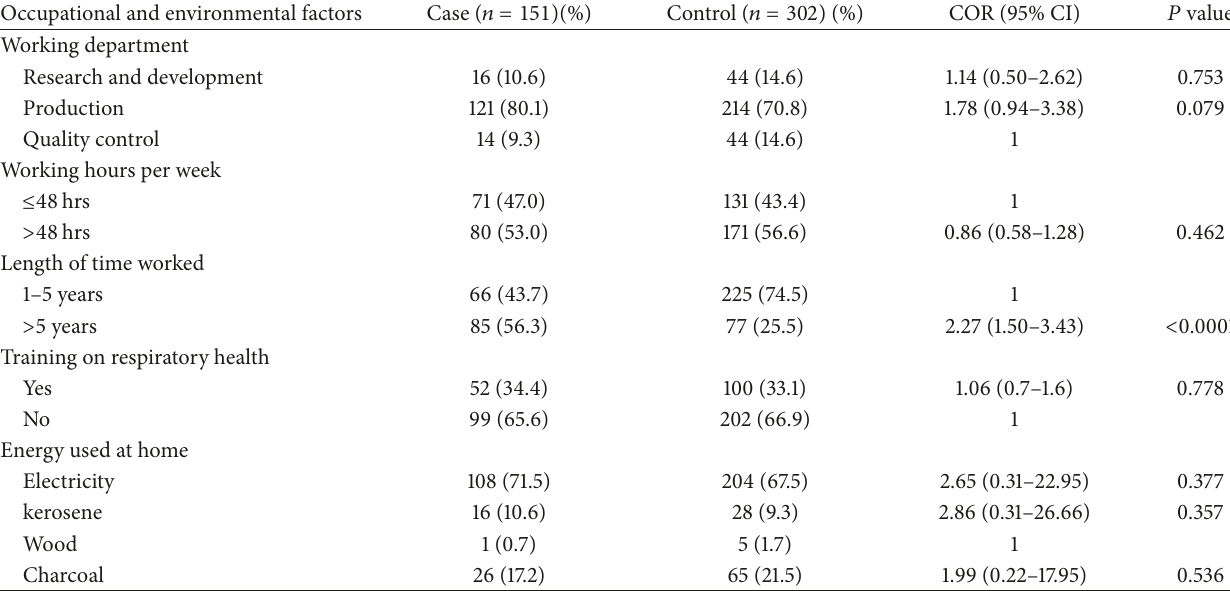
Table 5: Bivariate analysis of environmental and occupational factors and chronic respiratory symptoms among pharmaceutical factory workers in Addis Ababa, Ethiopia, May 2017.